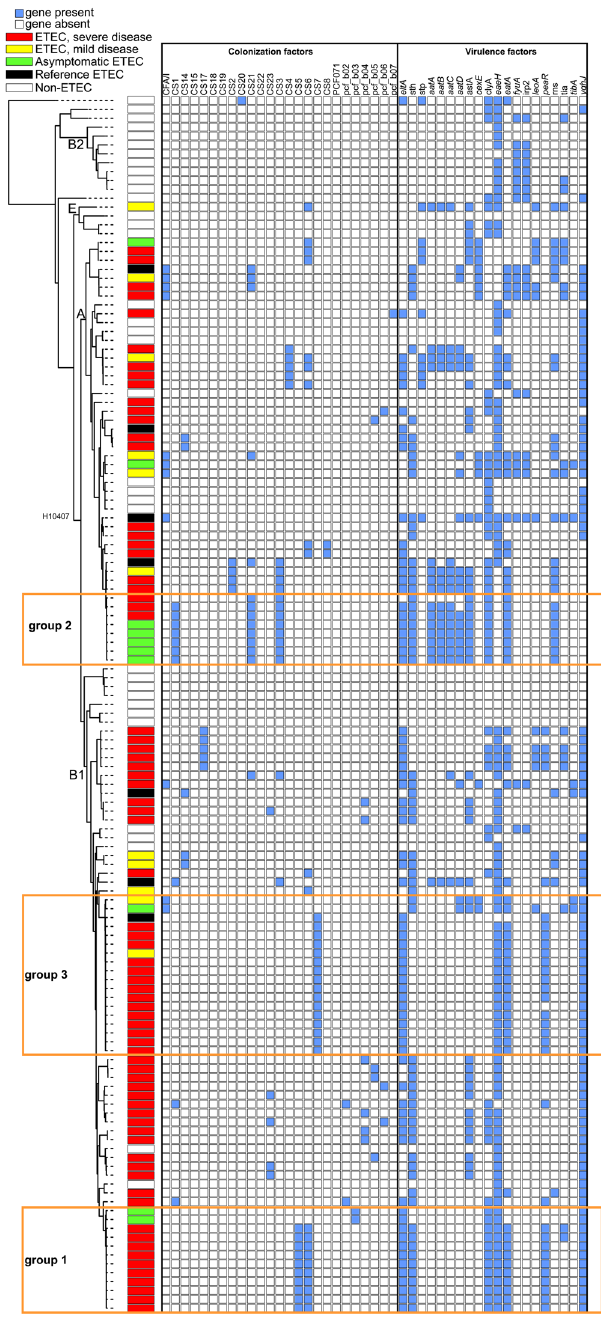
Figure 2. A core genome single nucleotide polymorphism (SNP) phylogeny of ETEC genomes sequenced in this study as well as reference E. coli genomes associated with a heatmap of BSR values of previously- characterized virulence and colonization factors (Table S3). Disease categories were assigned based on clinical observations. Orange brackets around genomes indicate lineages (Groups 1–3) compared to identify coding regions associated with the observed clinical presentations. The heatmap was associated with the phylogeny using the interactive tree of life